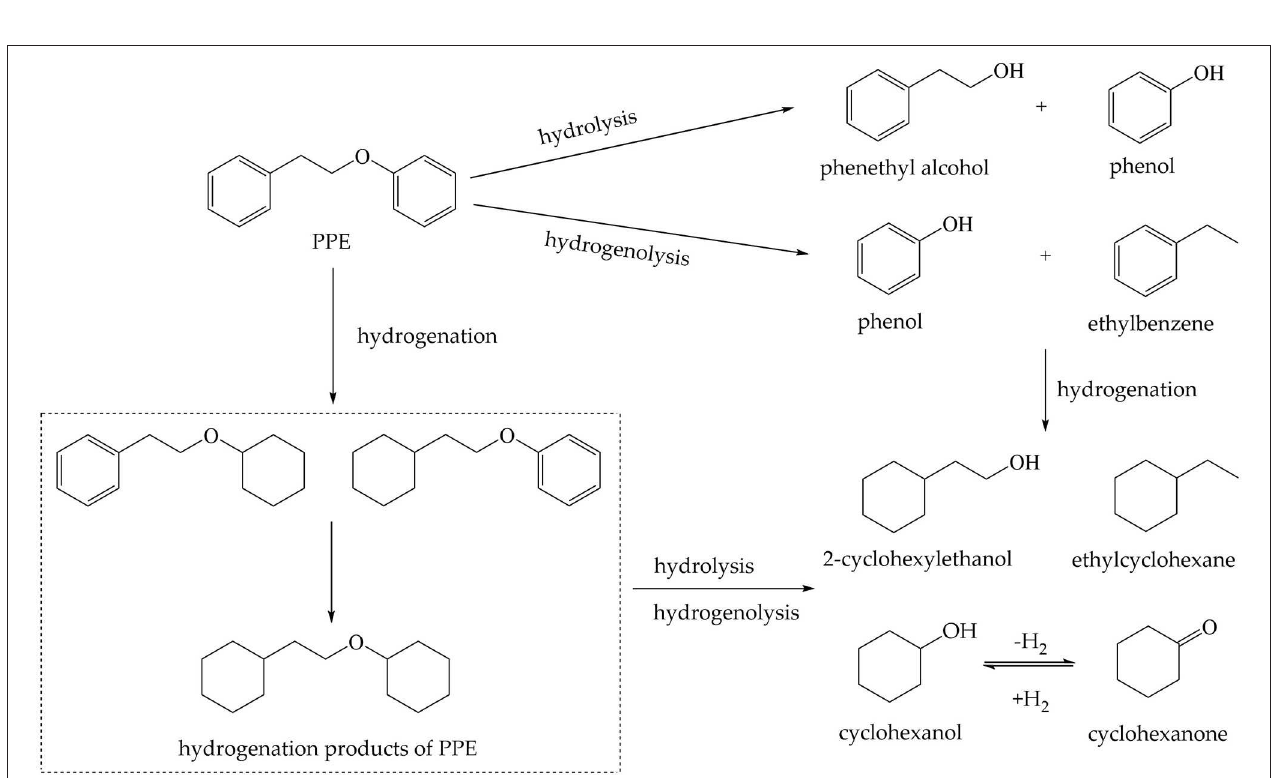
FIGURE 6 | Tentative reaction pathways for the hydrothermal treatment upgrading reaction of PPE.